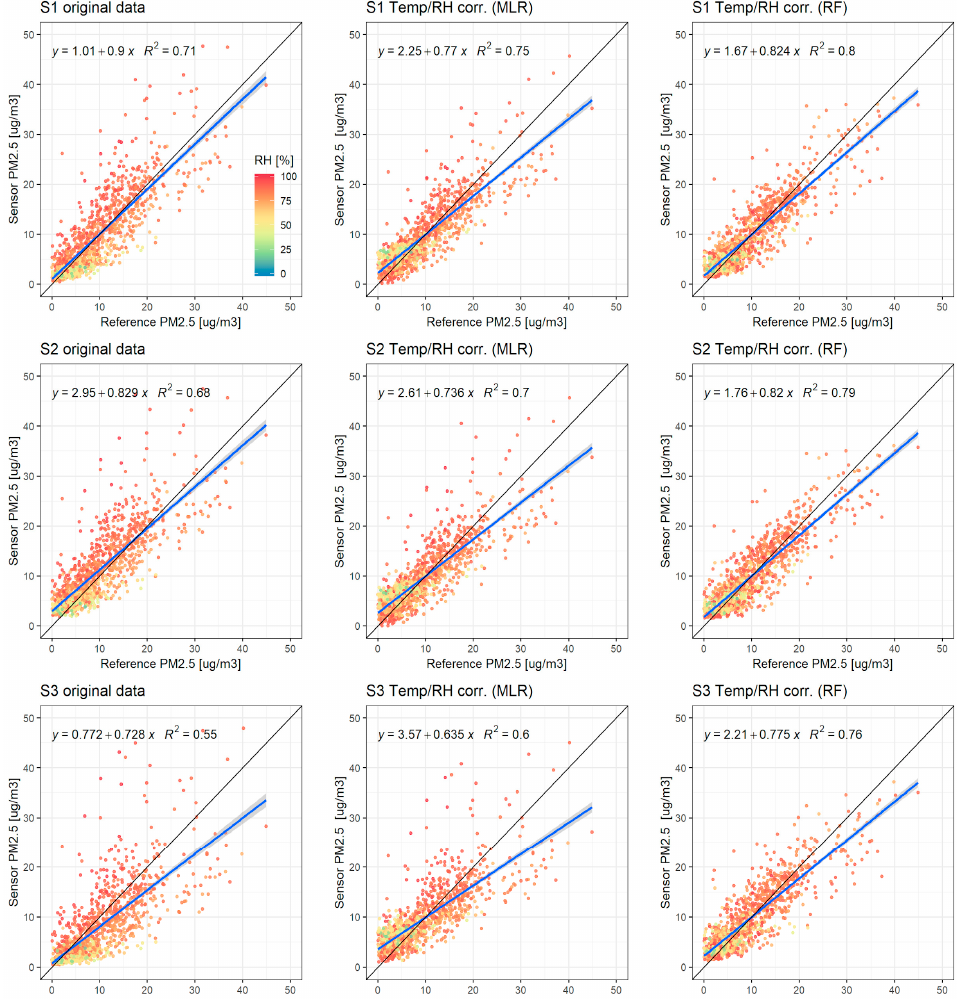
Figure 12. Comparison of scatterplots between hourly reference PM 2.5 observations and hourly sensor PM 2.5 observations for the test dataset of the original out-of-sensor data (left column), after correction for relative humidity and temperature effects using multiple linear regression (middle column), and after correction for relative humidity and temperature effects using a random forest model (right column). The three rows represent the data for S1, S2, and S3, respectively. The individual data points are coloured by the value of relative humidity.